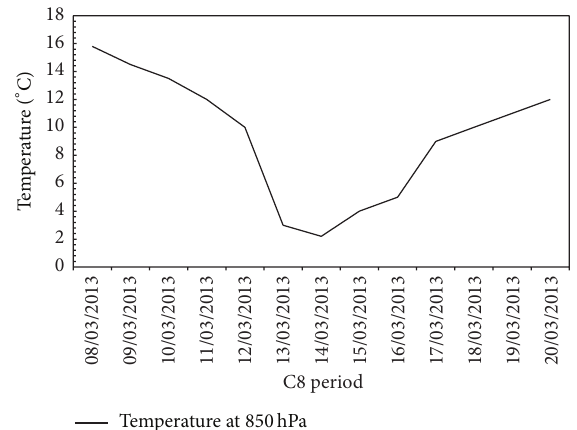
Figure 13: Temperature evolution at 850 hPa over Sfax in C8 period.